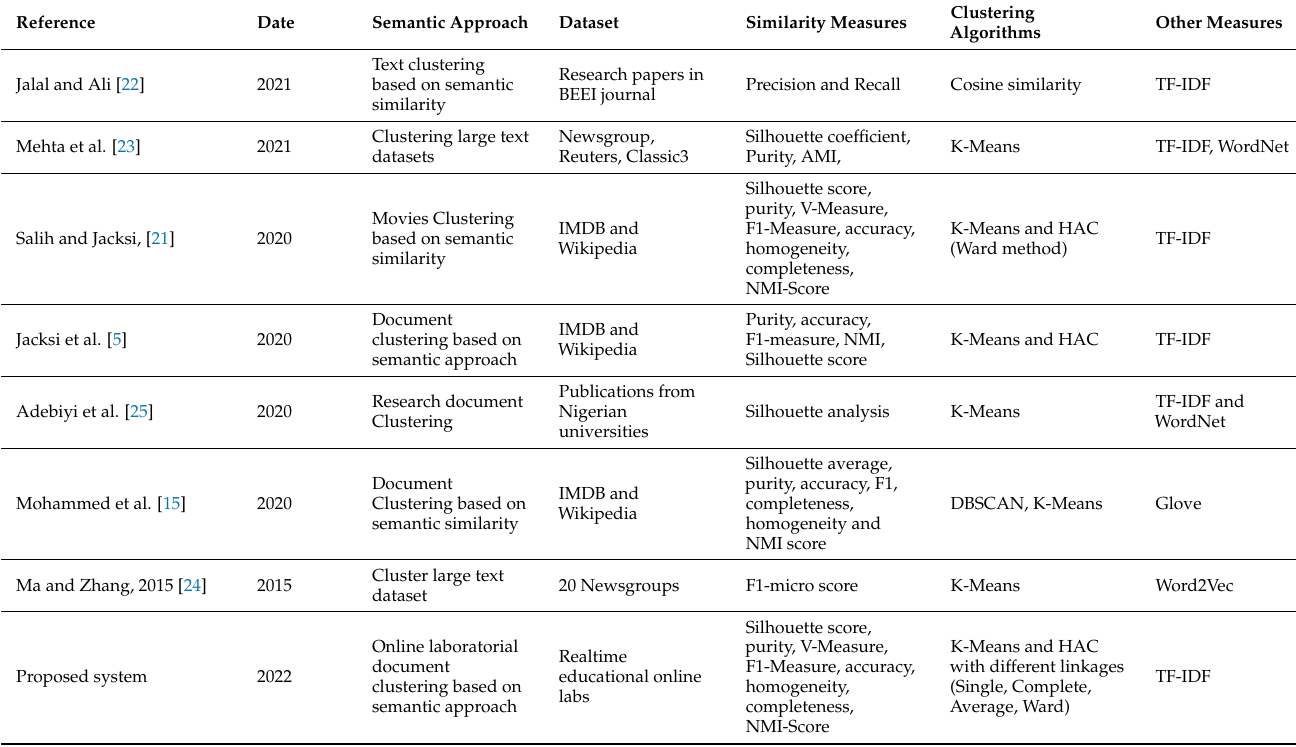
Table 3. Comparison of the proposed system with the